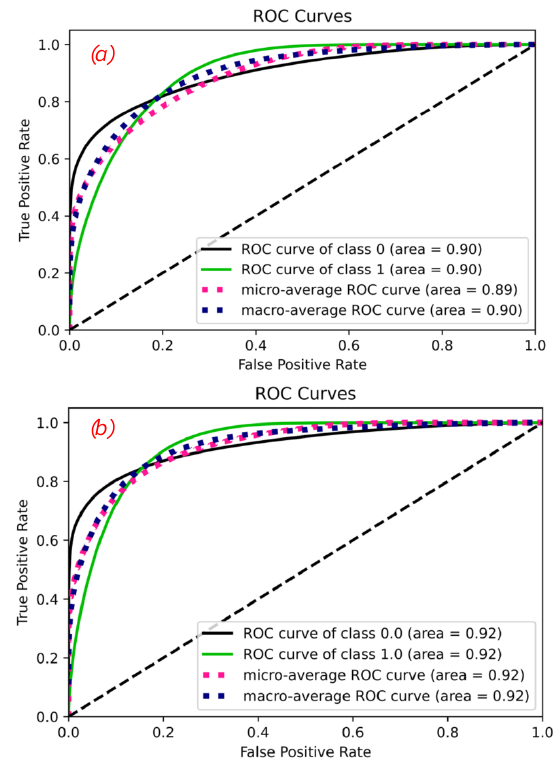
Figure 6. The ROC curve evaluation of the RF model for (a) Malatya and (b) Elazig parts.